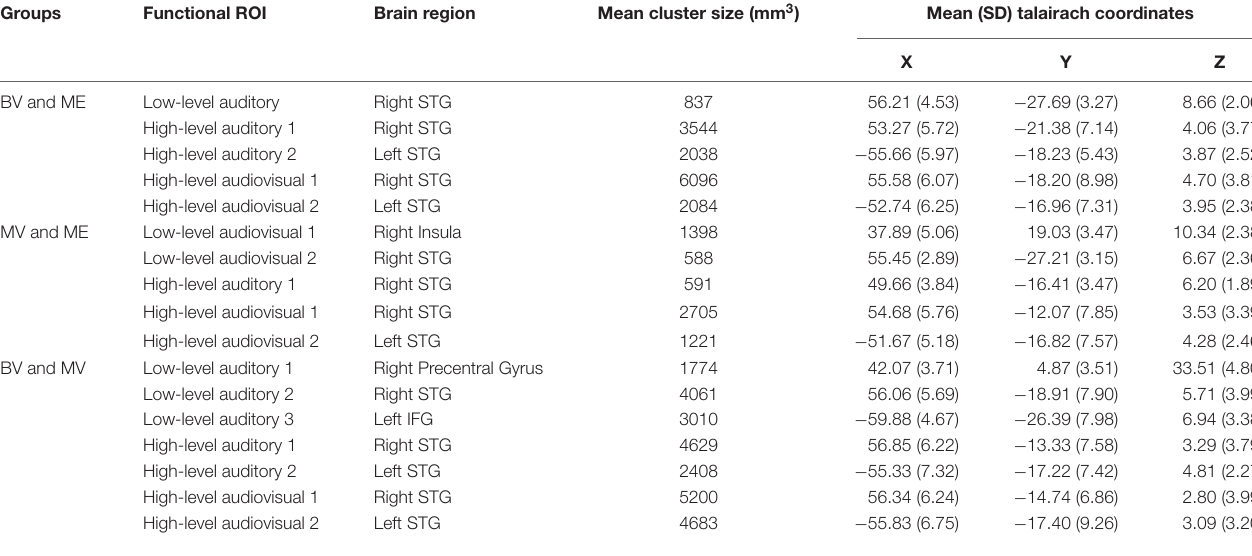
TABLE 1 | Conjunction ROIs containing voxels significantly activated in both participant groups with mean cluster size (SD) and mean Talairach coordinates (STG = superior temporal gyrus, IFG = inferior frontal gyrus).